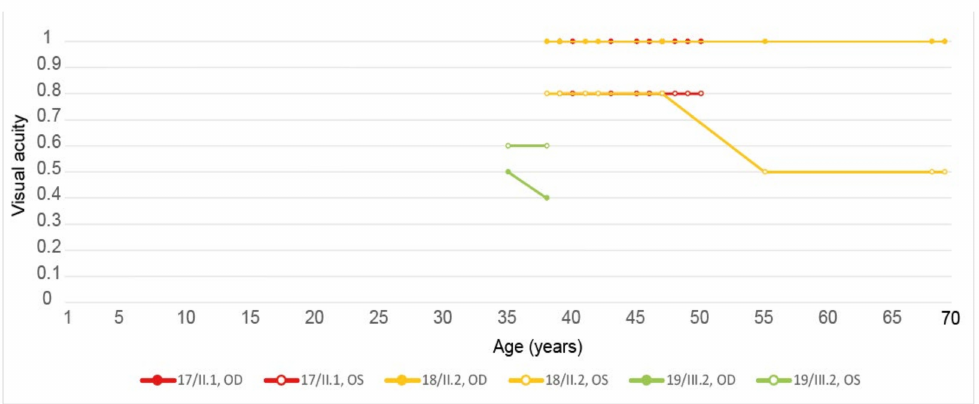
Figure 10. Evolution of the visual acuity in patients harboring the pathogenic c.422A>G p.(Tyr141Cys) PRPH2 variant. Best corrected visual acuity was assessed at indicated age (years), each dot indicating a clinical examination. OD, right eye; OS, left eye. Patient descriptions in text and